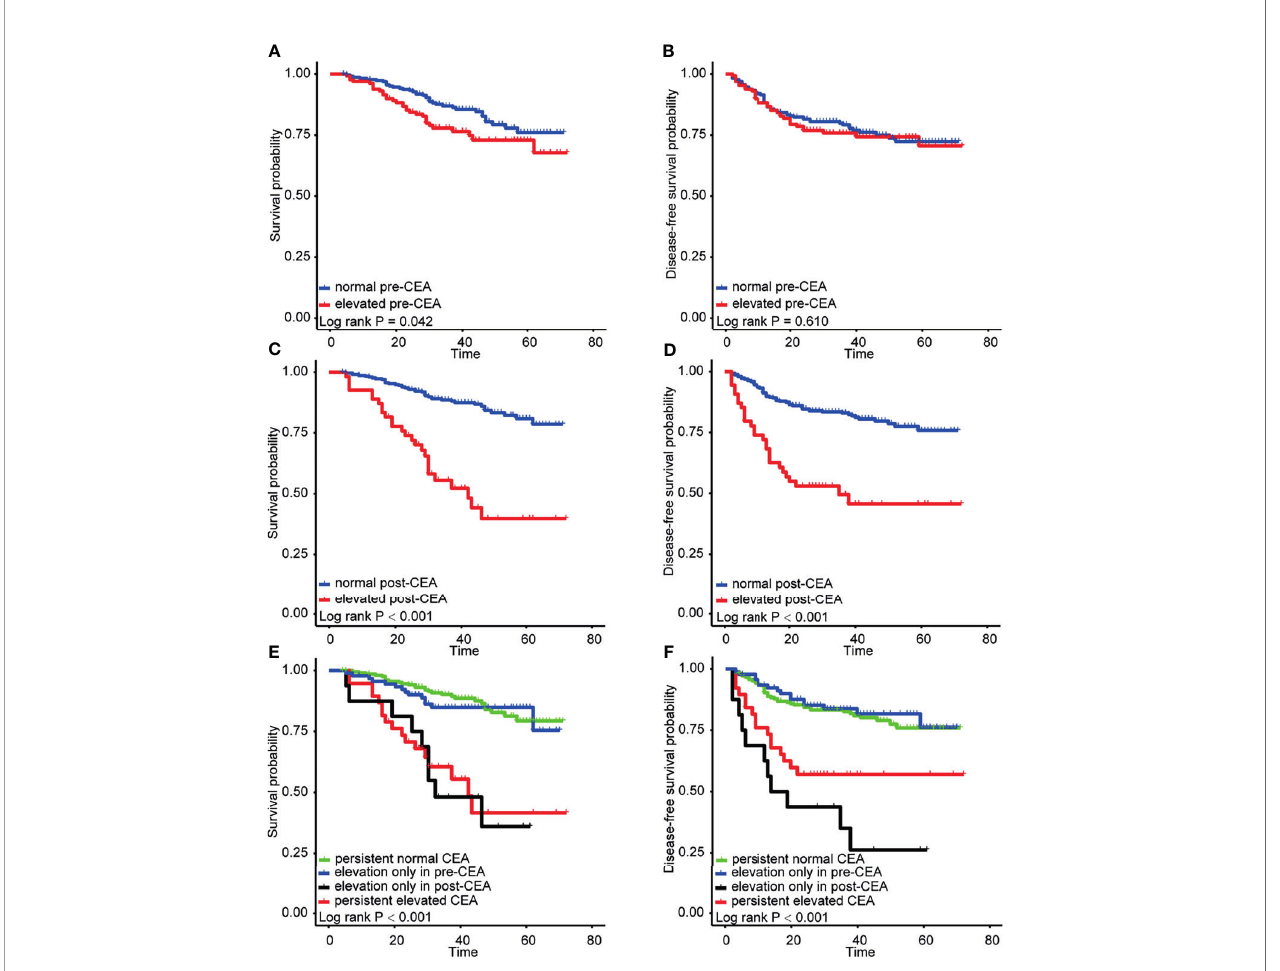
FIGURE 1 | Kaplan-Meier analysis for patients with colorectal cancer (CRC) in the discovery cohort strati fi ed by preoperative carcinoembryonic antigen (pre-CEA) and postoperative carcinoembryonic antigen (post-CEA). (A, C, E) were the survival curves for overall survival (OS). (B, D, F) were the survival curves for disease-free survival